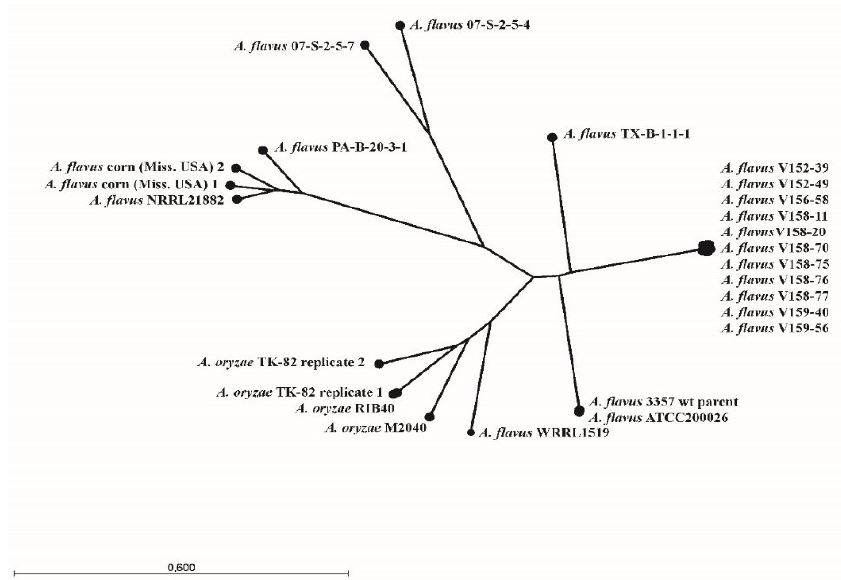
Figure 3. Neighbor-joining phylogenetic relationships of sequential isolated A. flavus strains and 14 A. flavus and A. oryzae strains obtained from the NCBI SRA database based on whole-genome sequencing data. The phylogenetic relationship was calculated from a distance matrix based on the average nucleotide identity.